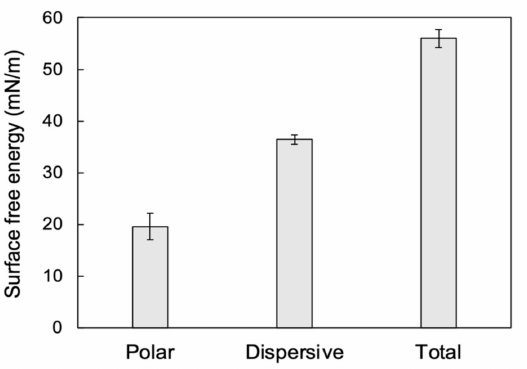
Figure 3. Surface free energies of the SiO 2 /pHEMA-based composite obtained using the Owens– Wendt theory.